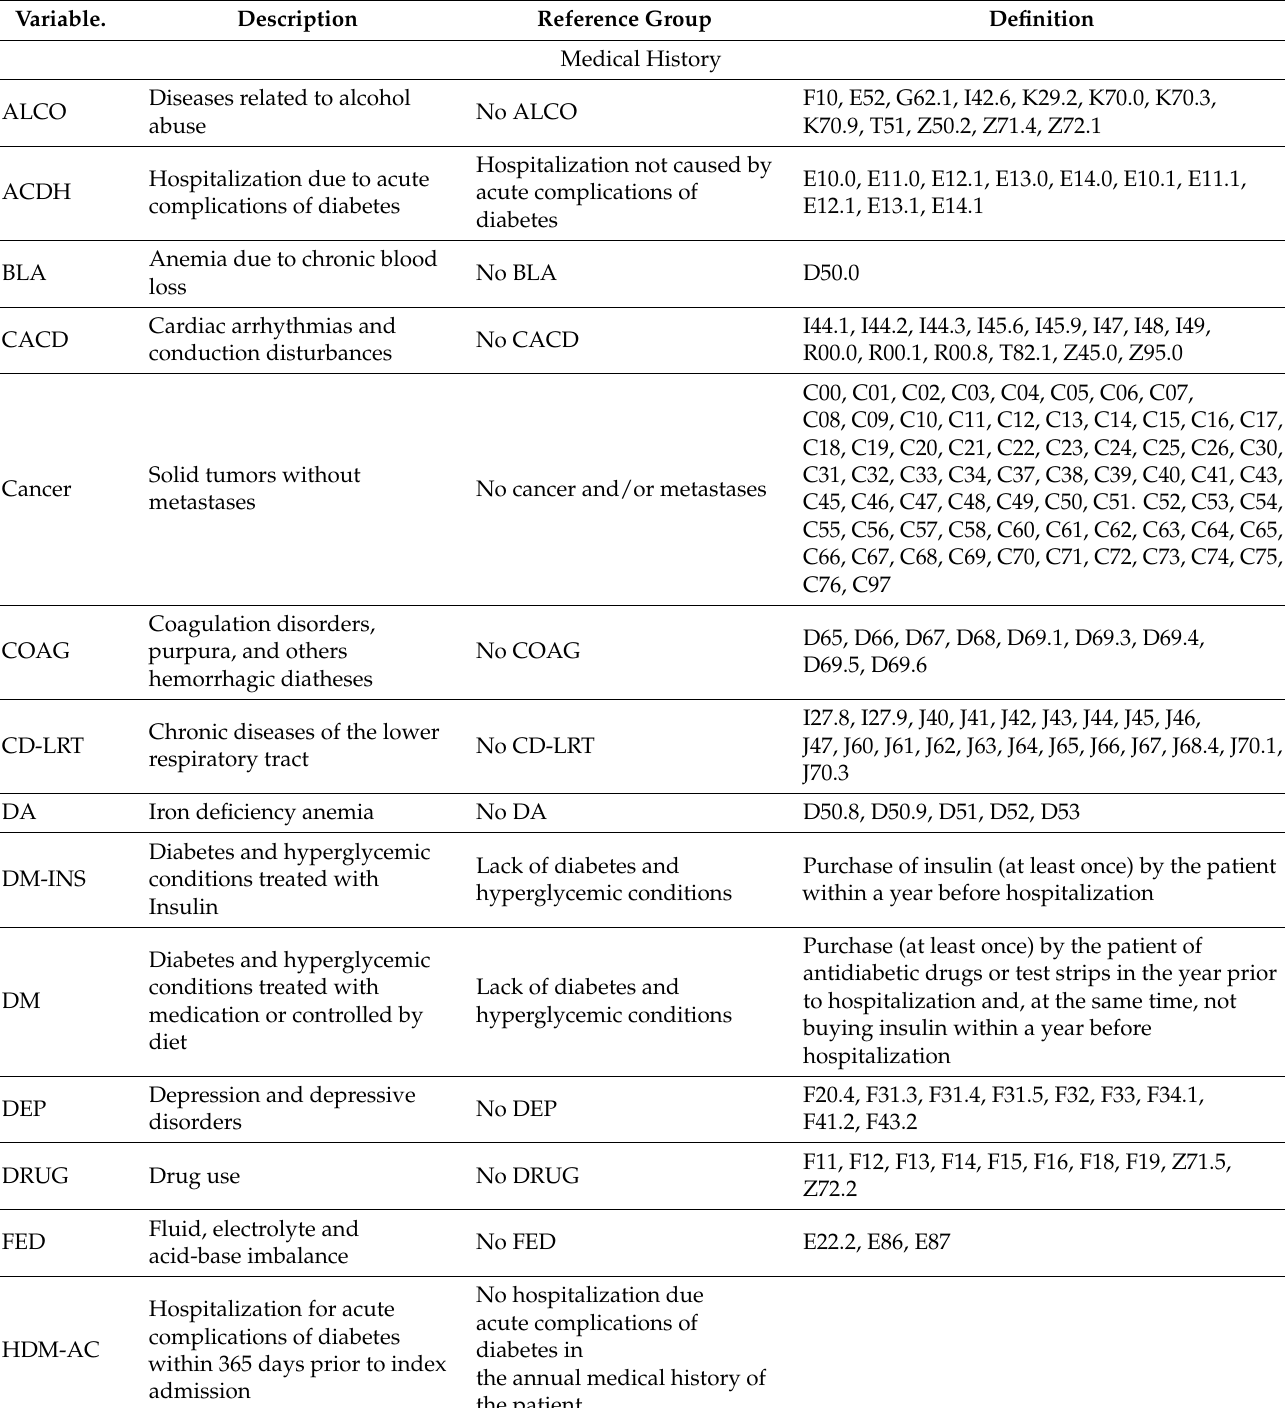
Table 1. Description of the variables